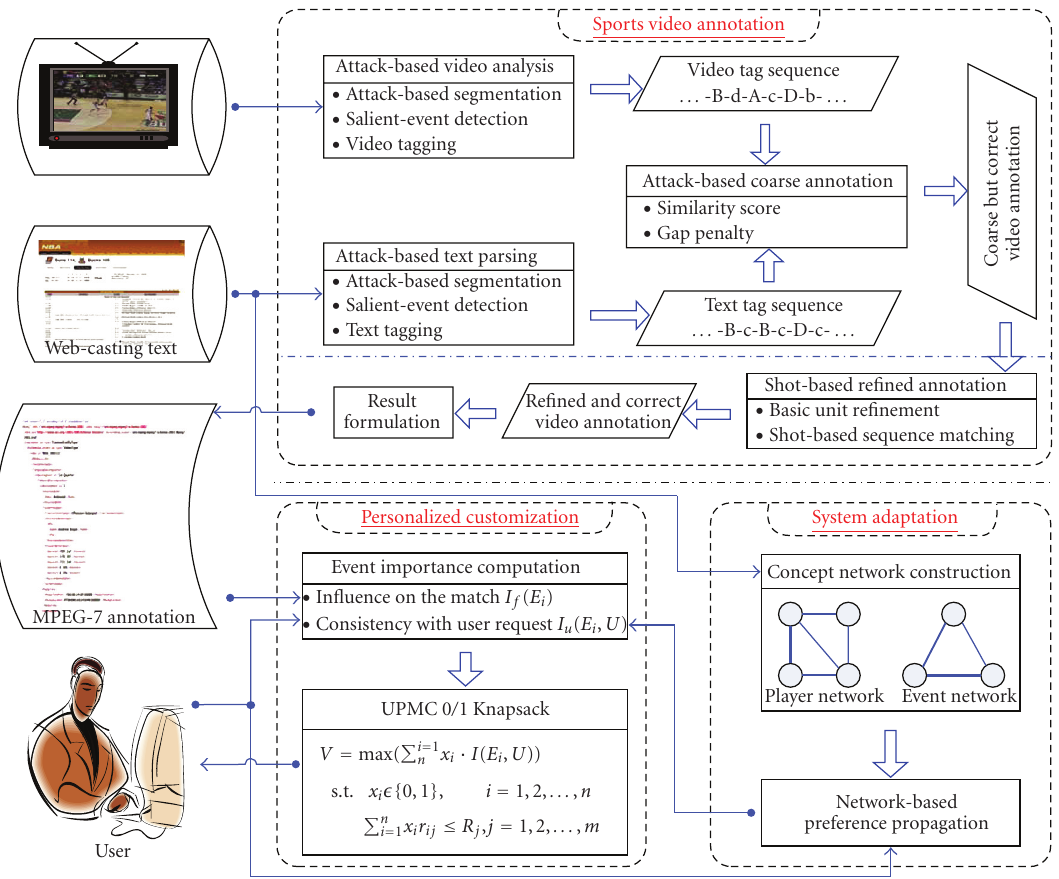
Figure 1: System framework of personalized sports video